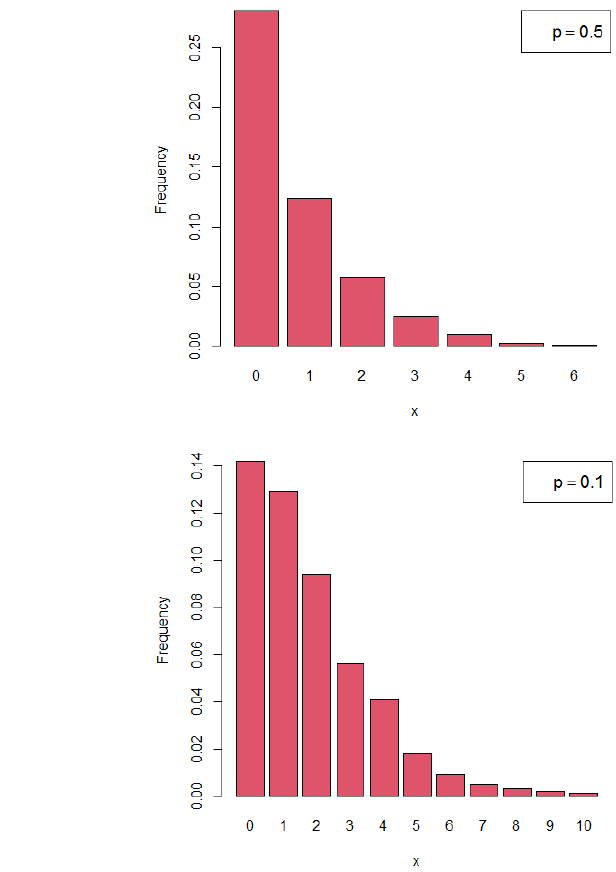
Figure 1. Pmf of BNDL distribution for some choices of p .